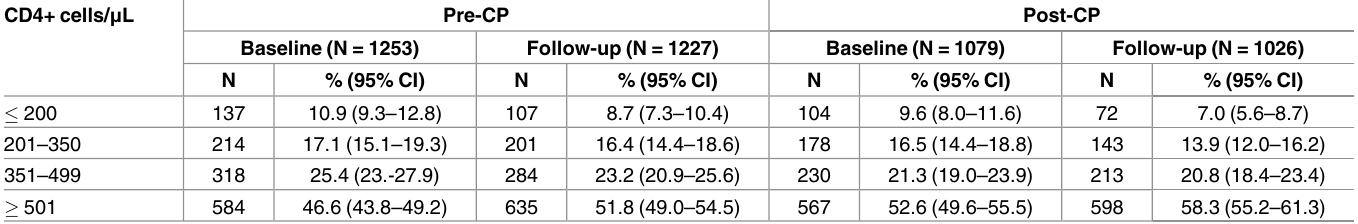
Table 4. CD4+ distribution in the study population, at baseline and 12-month follow up, Lombardy Region, Italy, comparing Pre-CP (2009–2010) and Post-CP (2011–2012).